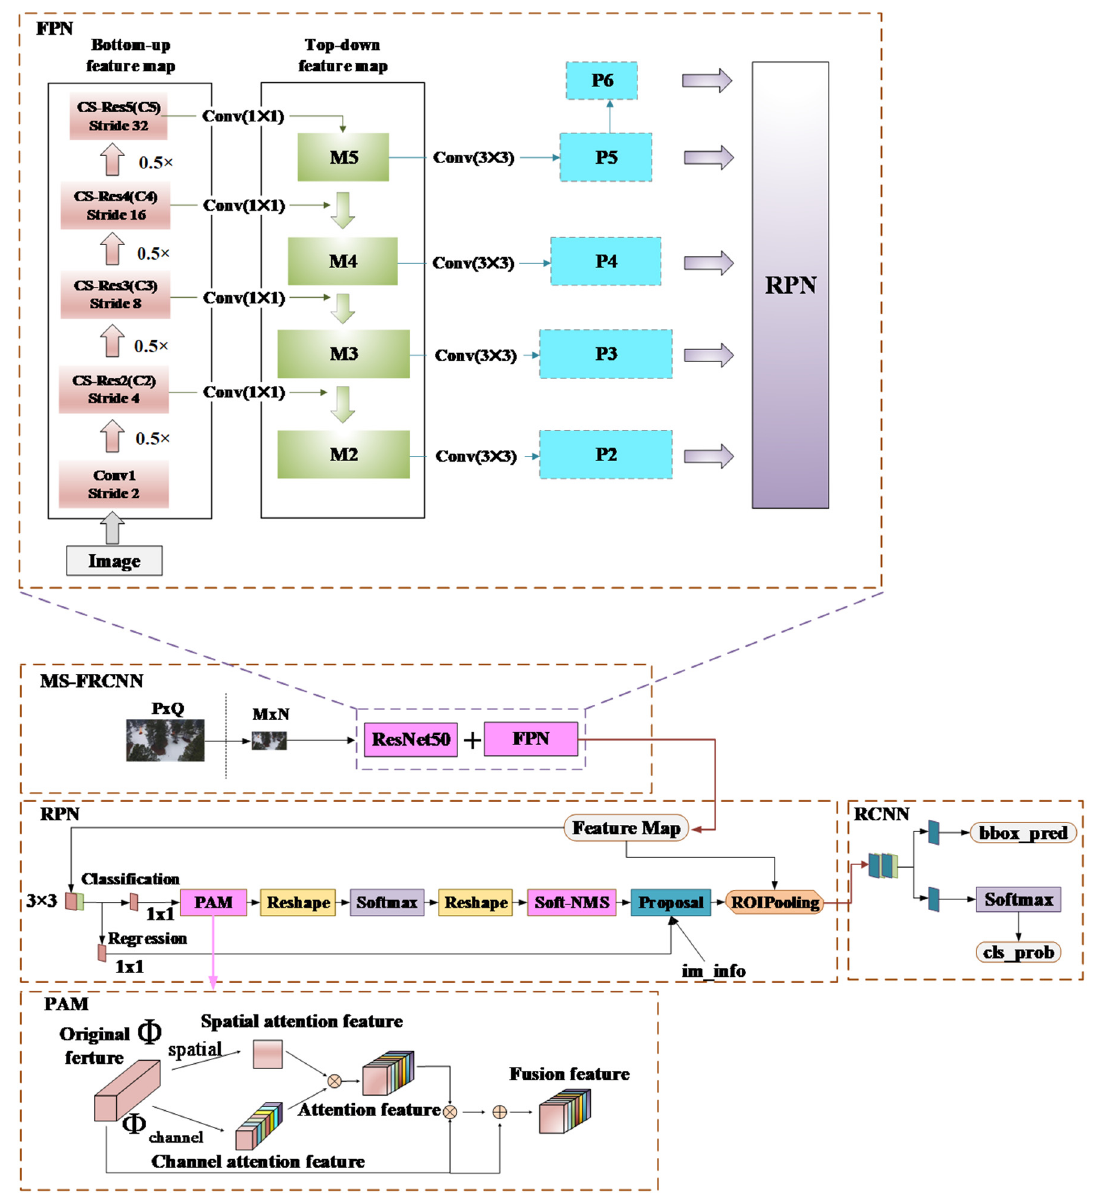
Figure 8. Overall architecture of the MS-FRCNN